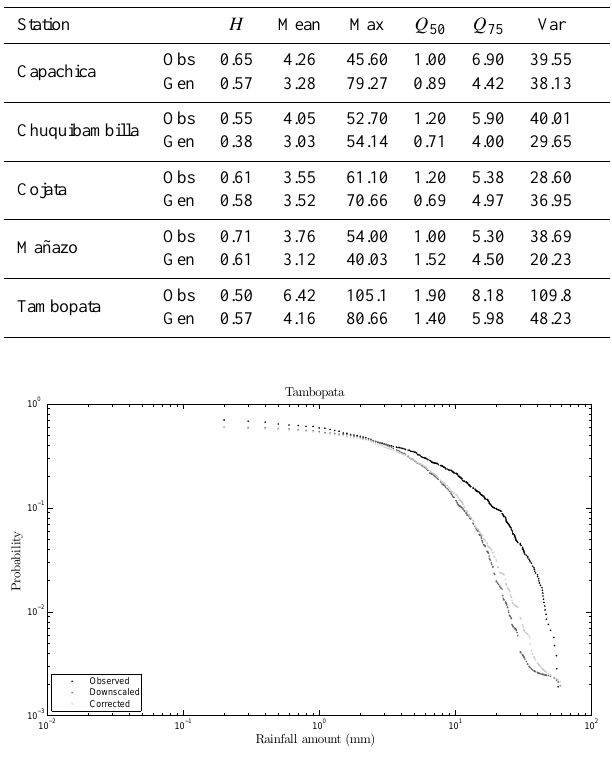
Figure 17. Exceedance probability of the Tambopata station dur- ing the wet season over an 8-year period. Comparison of observed, generated and corrected rainfall for the Tambopata station.